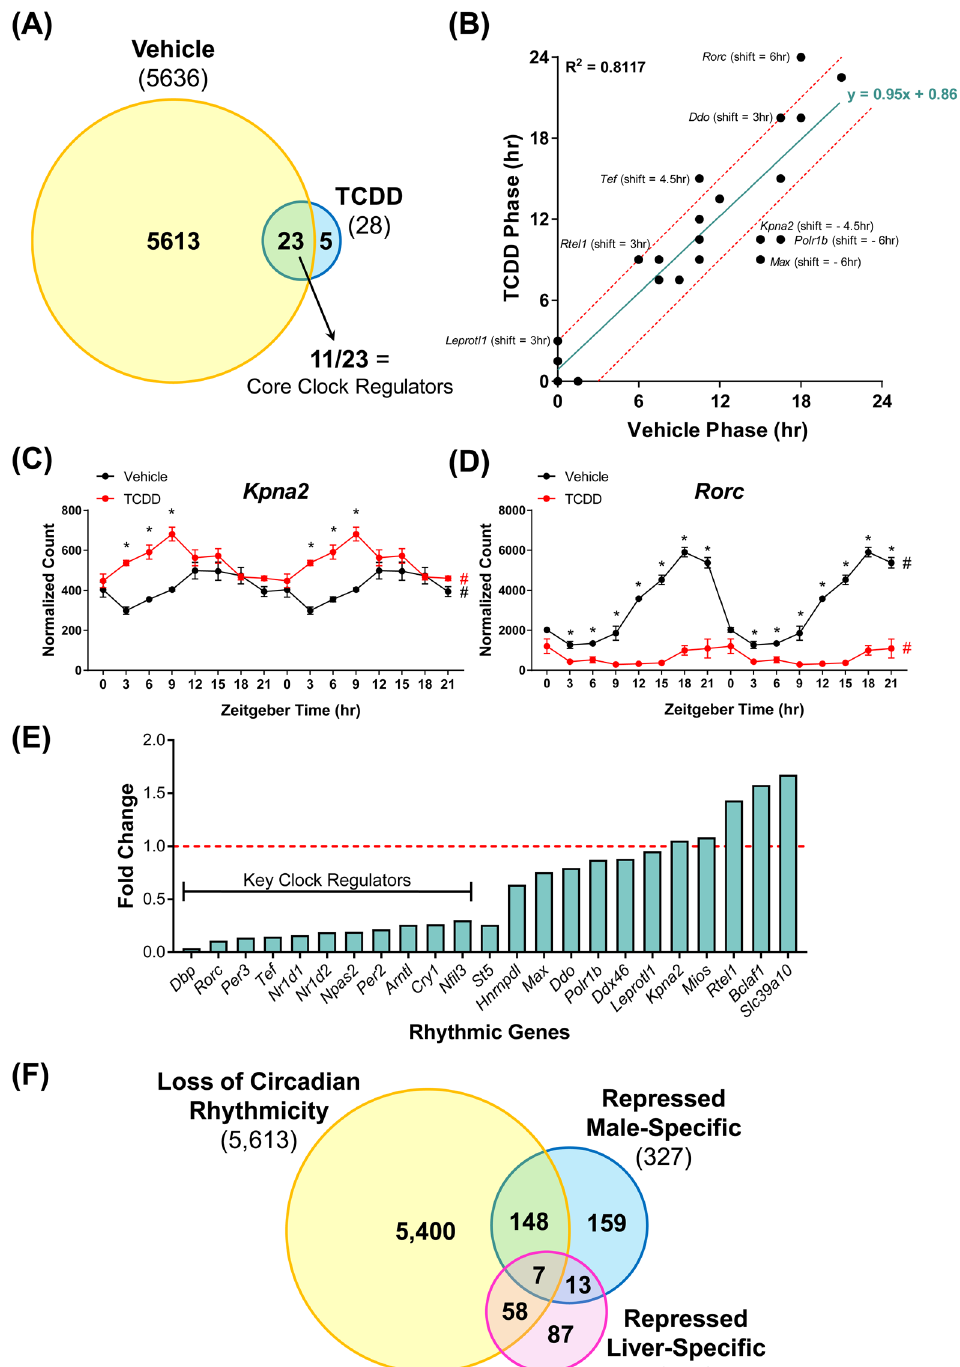
Figure 2. The effect of TCDD on the diurnal rhythmicity of hepatic gene expression in male C57BL/6 mice orally gavaged with sesame oil vehicle or 30 μ g/kg TCDD every 4 days for 28 days. ( A ) The number of hepatic genes which exhibited rhythmic expression in vehicle- and TCDD-treated mice. 5,613 of 5,636 (99.6%) rhythmic genes lost their diurnal oscillation pattern following treatment, while 23 genes exhibited rhythmicity in both vehicle- and TCDD-treated mice. Rhythmicity was determined using JTK_CYCLE (BH q ≤ 0.1). ( B ) Correlation between the acrophases (time at which cycle peaks/crests) of rhythmic expression in vehicle- and TCDD-treated mice. The linear regression line is shown in green, while the red dashed lines represent acrophase shifts of ± 3 h. Genes falling within the red dashed lines exhibited negligible acrophase shifts of ≤ 1.5 h. TCDD decreased the acrophase of ( C ) Kpna2 (as well as Polr1b and Max , not shown), while increasing the acrophase of ( D ) Rorc (as well as Leprotl1 , Rtel1 , Tef , and Ddo , not shown). Data points represent the average of 3 individual mice ± standard error of the mean. Posterior probabilities ( * P1(t) ≥ 0.80) comparing vehicle and TCDD were determined using an empirical Bayes method. Diurnal rhythmicity was assessed using JTK_CYCLE (#